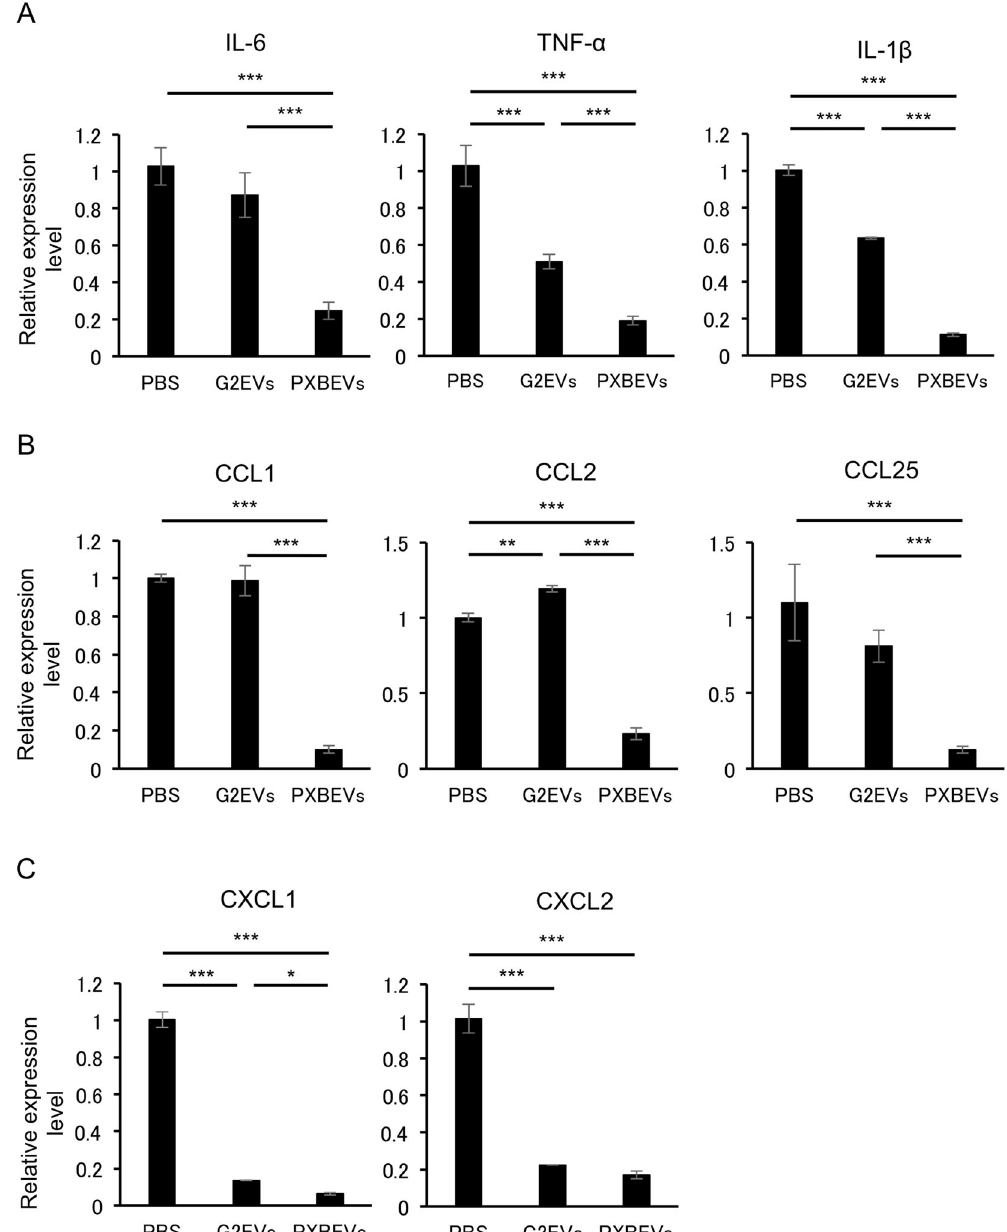
Fig. 4 Hepatocyte-derived EVs affected the expression of proin fl ammatory cytokines and chemokines of KCs. A – C IL-1 β , IL-6, TNF- α , CCL1, CCL2, CCL25, CXCL1, CXCL2, MMP-9, and MMP-12 mRNA expression in KCs of mice treated with CCL 4 + PBS, CCL 4 + HepG2-EVs, or CCL 4 + PXB-EVs were measured by reverse-transcription quantitative polymerase chain reaction (RT-qPCR), and each sample was normalized relative to β -actin expression. Data represent the mean ± SD of triplicate experiments. Statistical analysis was performed using one-way ANOVA and subsequent Tukey ’ s HSD method. * P <